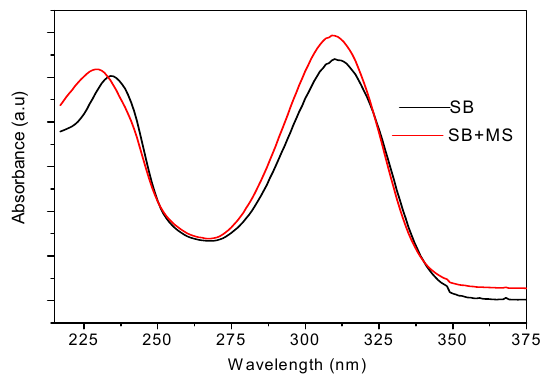
Figure 6. UV-Vis spectra of pure SB solution (black, SB) and SB solution after mild steel immersion (red, SB+MS).